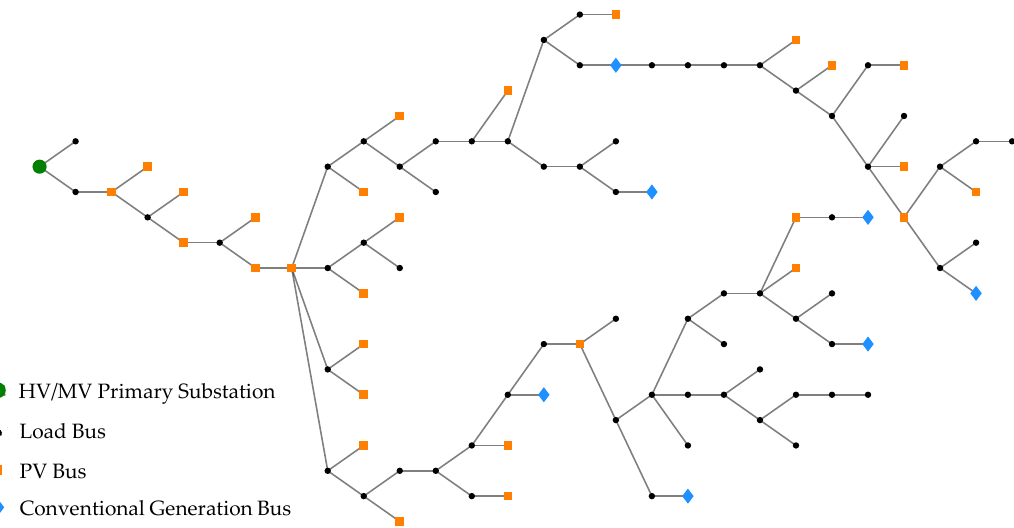
Figure 9. Studied distribution feeder.